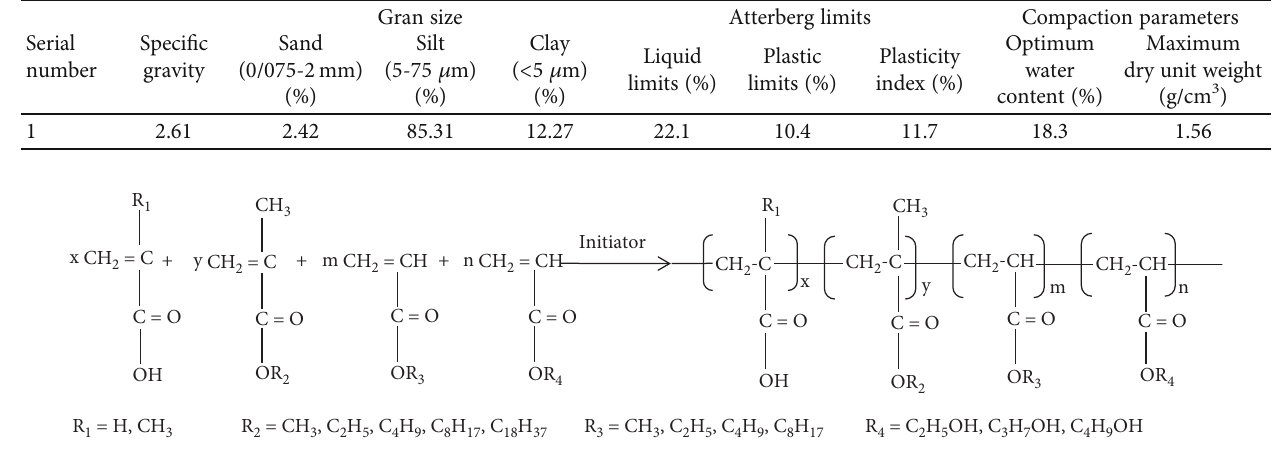
Figure 1: Polymerization reaction of ZM. Table 2: Physicochemical characteristics of